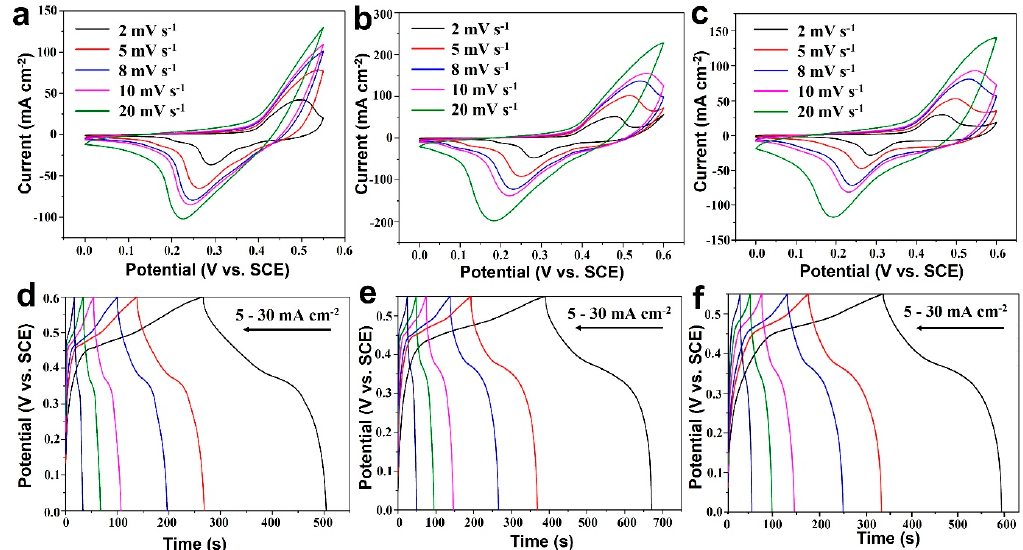
Figure 4. CV ( a – c ) and GCD ( d – f ) curves of the CF@ZnCuNiO x NAs collected without light illumination ( a , d ), under light illumination but without cooling water ( b , e ), and with light illumination and cooling water ( c , f ).